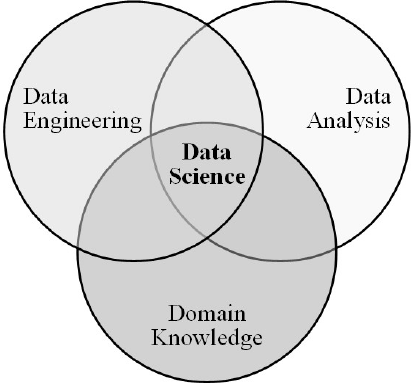
Figure 1. Components of domain-specific data-analysis [22].